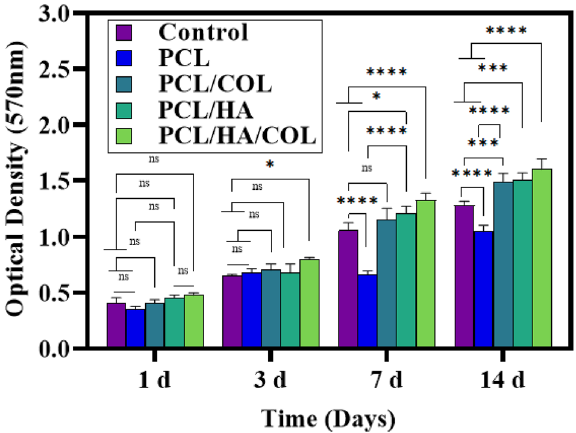
Figure 4. The proliferation rate of hADSCs on the scaffolds after 1,3,7 to 14 days, and determined by MTT assay. (n = 3, *P ≤ 0.05, **P ≤ 0.01, ***P ≤ 0.001, ****P ≤